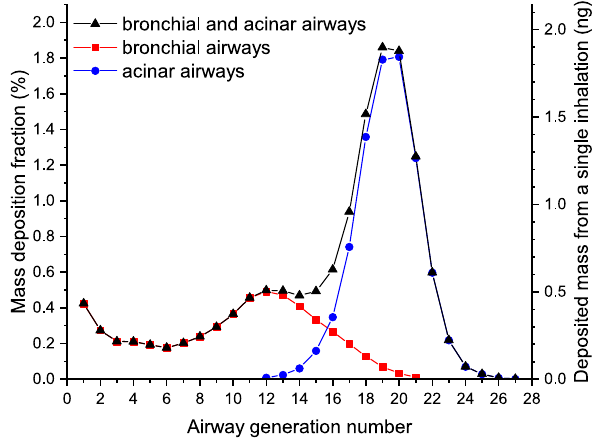
Figure 4. Mass deposition fraction of inhaled particles (left axis) and deposited mass from a single inhalation (right axis) upon exposure to cough-generated droplets and aerosol particles as the function of airway generation